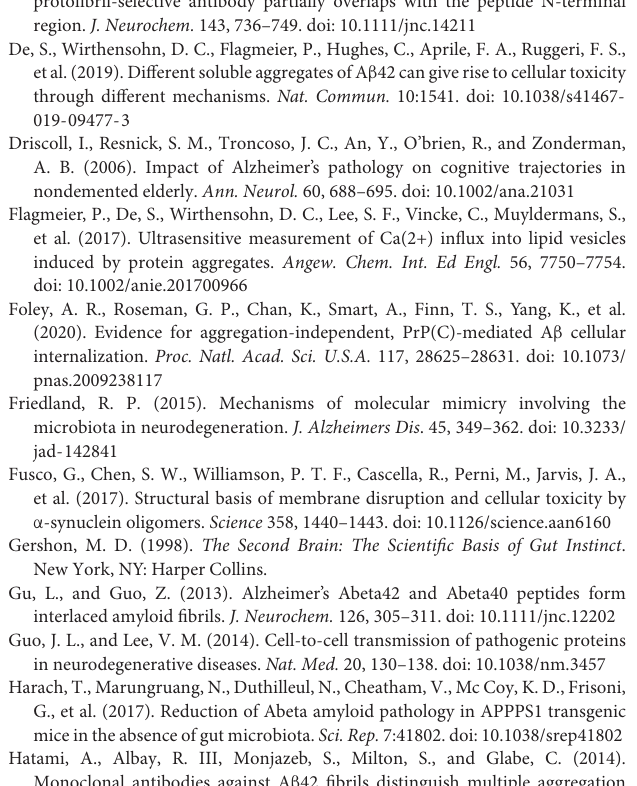
Supplementary Figure 3 | Comparison of the dynamic distribution of A β 42 in APP/PS1 and C57BL/6J. The levels of total A β 42 (A,D) , A β 42 Os (B,E) , and A β 42 Ms (C,F) in the stomach, duodenum, jejunum, ileum, colon, and cecum and their lysates from APP/PS1 and C57BL/6J at 3-month-old ( n = 4) or 9-month-old APP/PS1 ( n = 4). Data are presented as means ± SEM. Two-way analysis of variance (ANOVA) was used for multigroup comparisons. Statistical significance is indicated in the figures by ** p < 0.01, *** p < 0.001 and **** p < 0.0001. Supplementary Figure 4 | Representative confocal fluorescence images of the duodenum, jejunum, ileum, cecum, and colon of 3-month-old C57BL/6J mice double-stained with thioflavin S and Cy3-1F12 (Scale bar: 100 µ m). Supplementary Figure 5 | Representative confocal fluorescence images of the duodenum, jejunum, ileum, cecum, and colon of 9-month-old C57BL/6J mice double-stained with thioflavin S and Cy3-1F12 (Scale bar: 100 µ